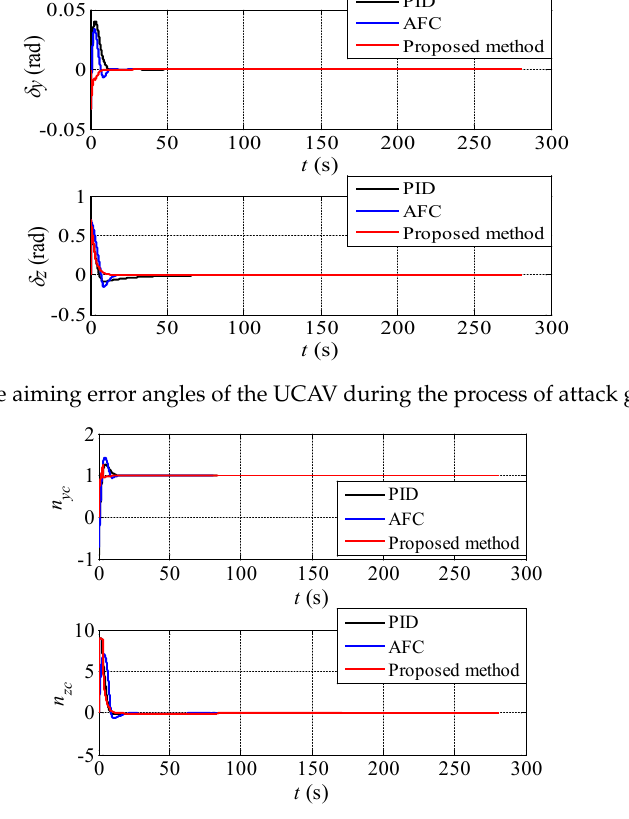
Figure 10. The actual control overloads of the UCAV during the process of attack